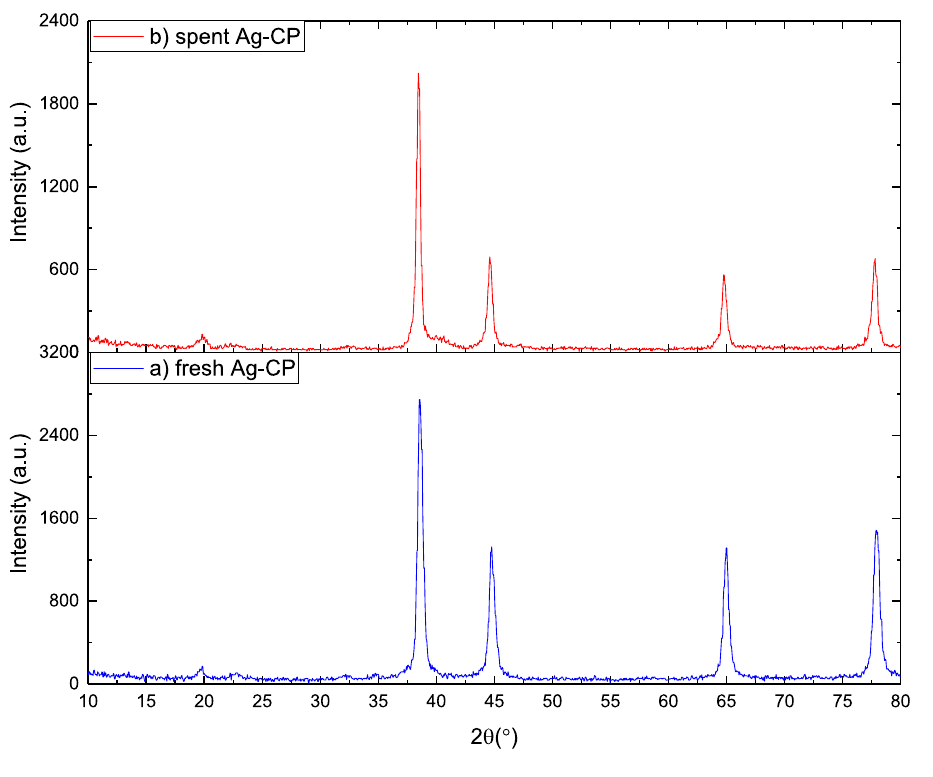
Figure 10. PXRD patterns of the ( a ) fresh Ag–CP and ( b ) spent Ag–CP.